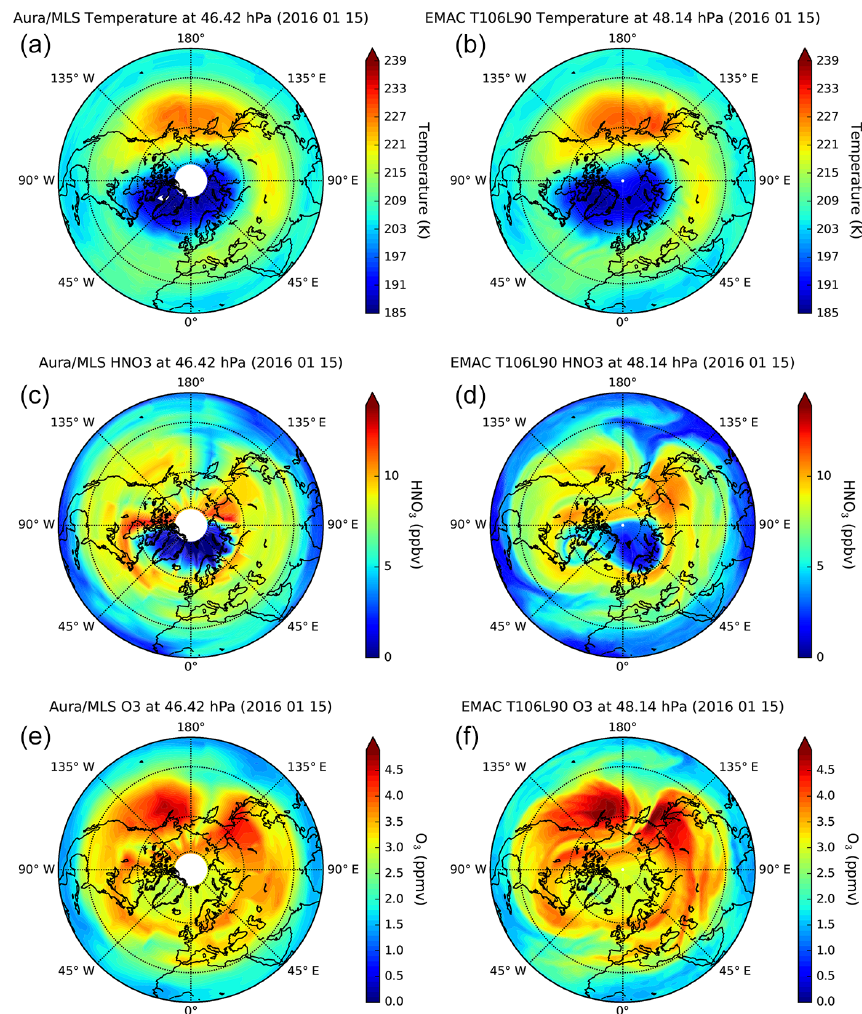
Figure 12. Temperature, HNO 3 and O 3 distribution measured by Aura/MLS (a, c, e) and simulated by EMAC T106L90 (b, d, f) at ∼ 50hPa on 15 January